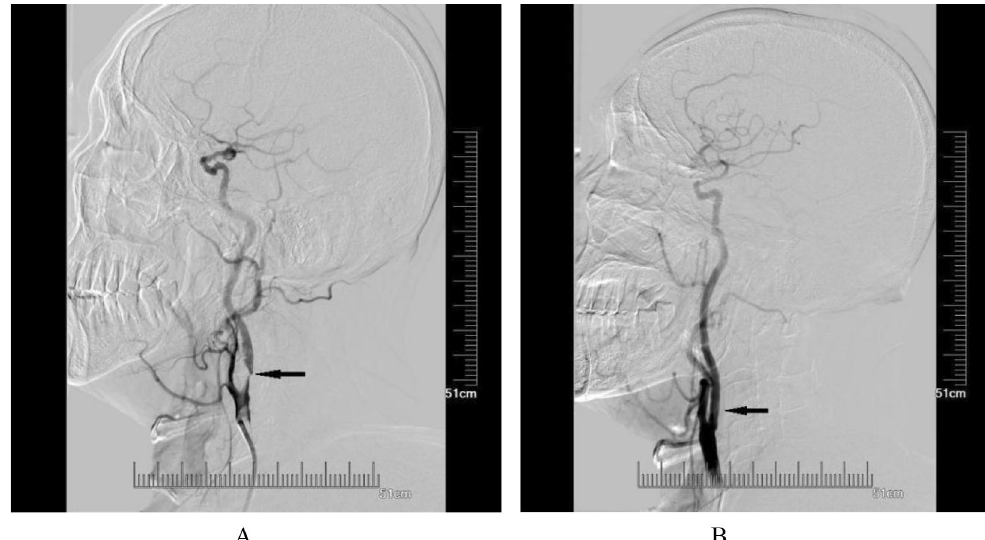
Figure 1. The digital subtraction angiography before and after carotid artery stenting. ( A ) The digital subtraction angiography showed the stenosis in the carotid artery was Grade 3 (> 90%) before carotid artery stenting. ( B ) The stenosis in carotid artery was improved obviously improved and the reperfusion was restored (TICI 3) after carotid artery stenting.